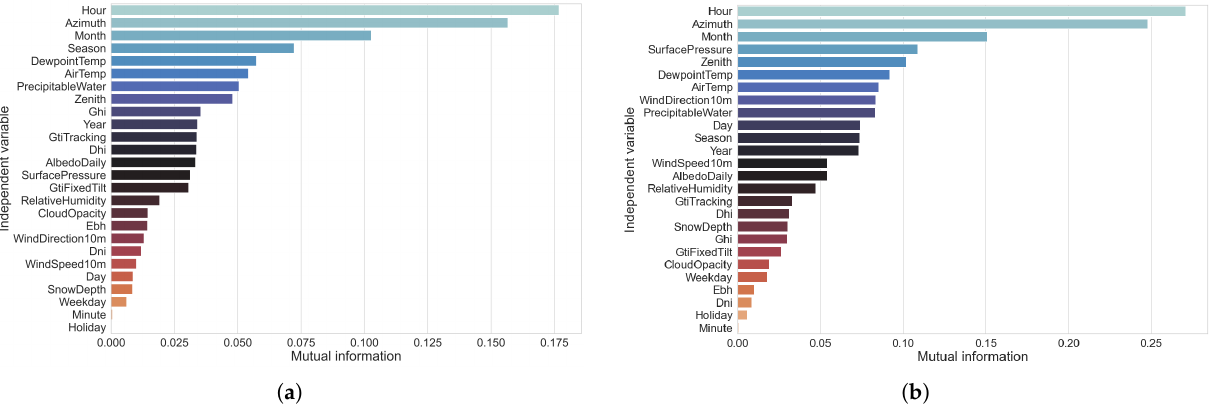
Figure 5. Mutual information gain with regard to our independent features and target variable for the UCID and RE- FIT datasets. ( a ) UCID dataset. ( b ) REFIT